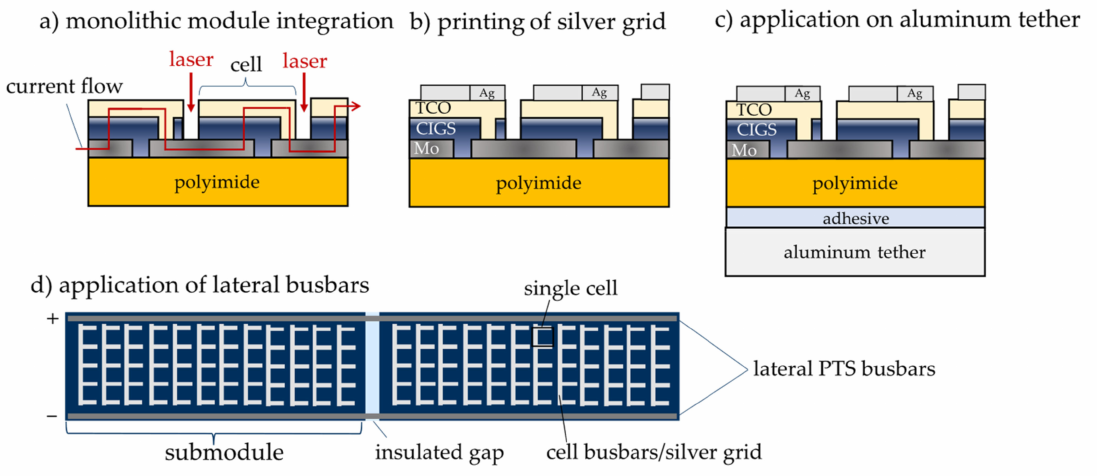
Figure 2. PTS fabrication: ( a ) laser-based monolithic integration of submodules; ( b ) application of silver grid in an ink jet printing process; ( c ) application of the cells with substrate to the bare aluminum tether using; ( d ) application of lateral busbars for parallelization of submodules and contacting to the